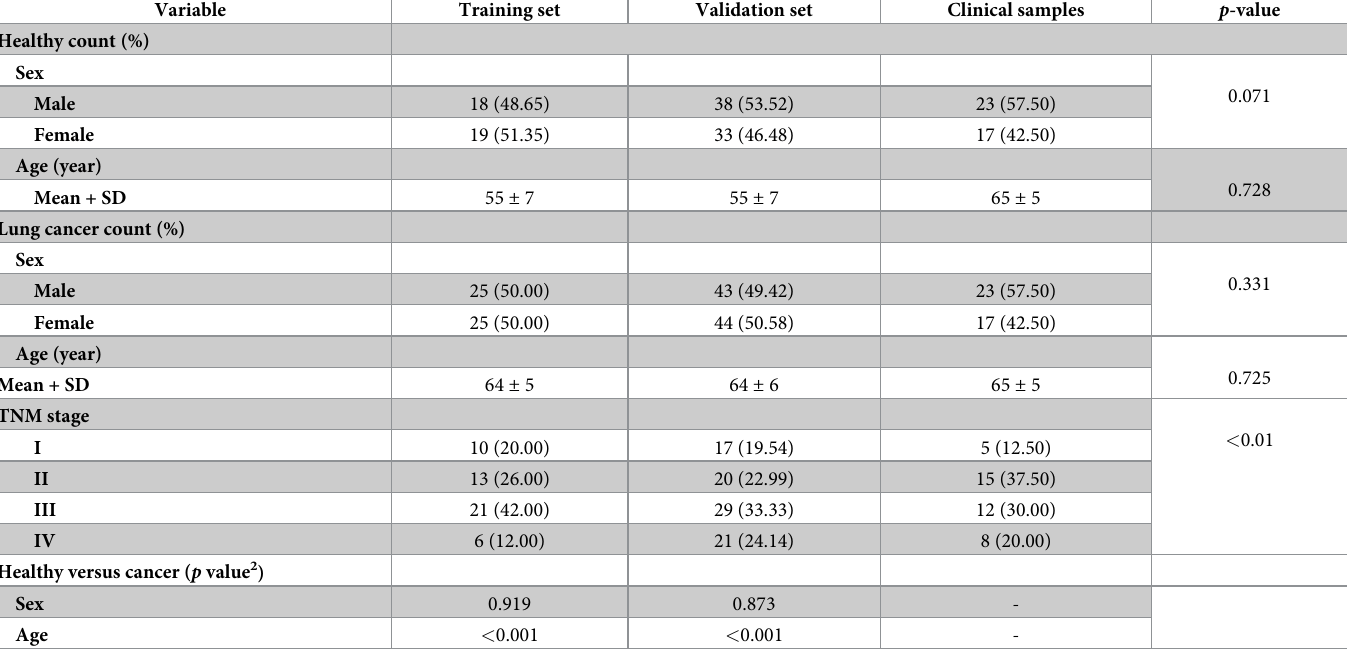
Table 3. Clinical features of the lung cancer